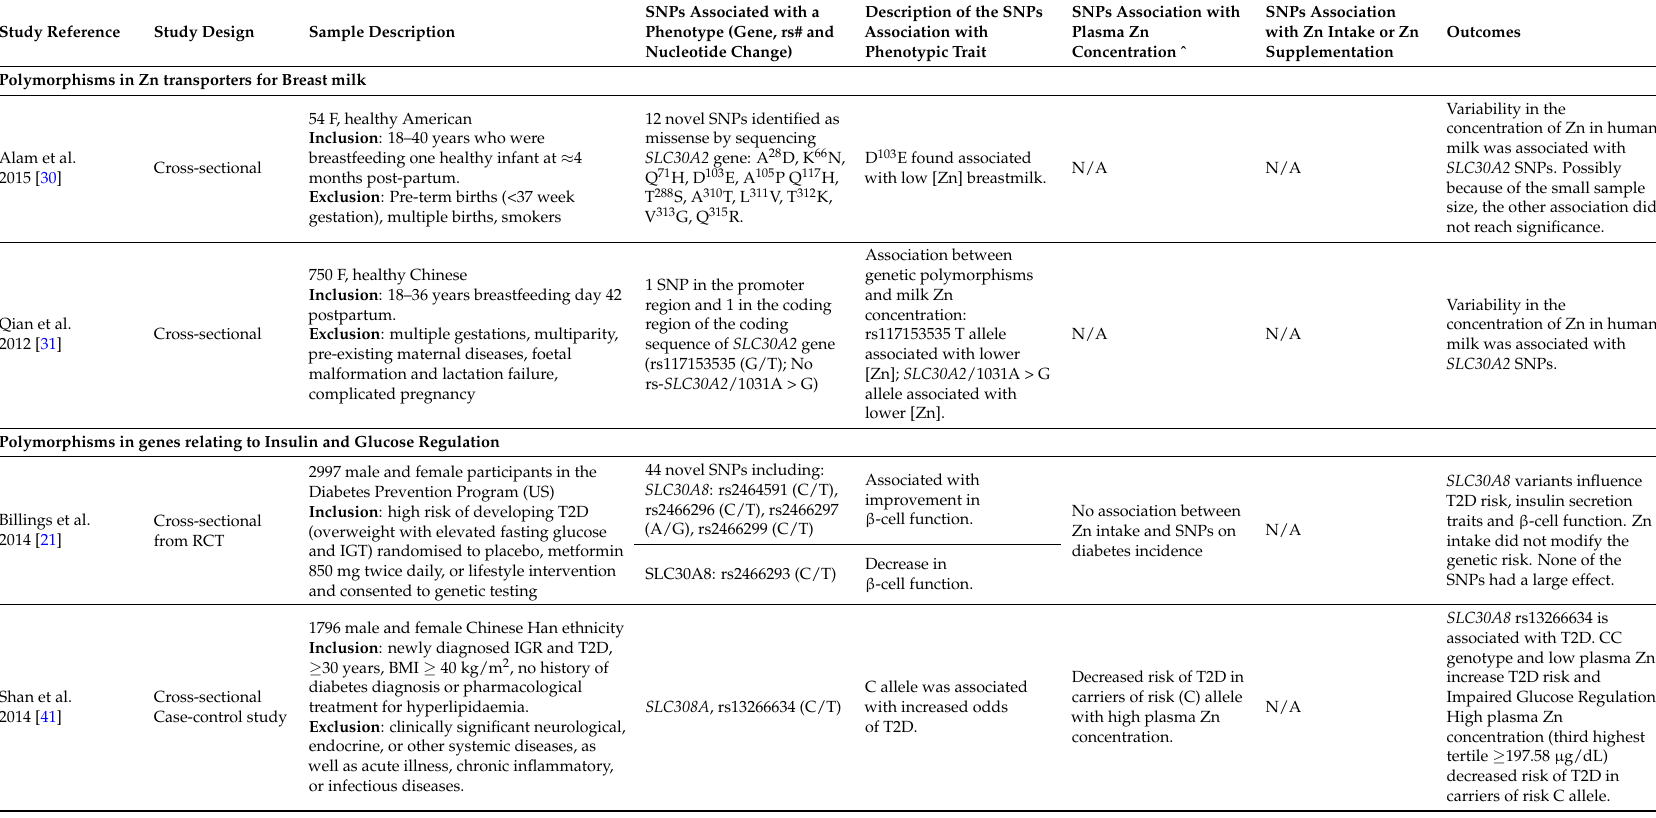
Table 1. Data extraction of each study identified. T1D, type 1 diabetes; T2D, type 2